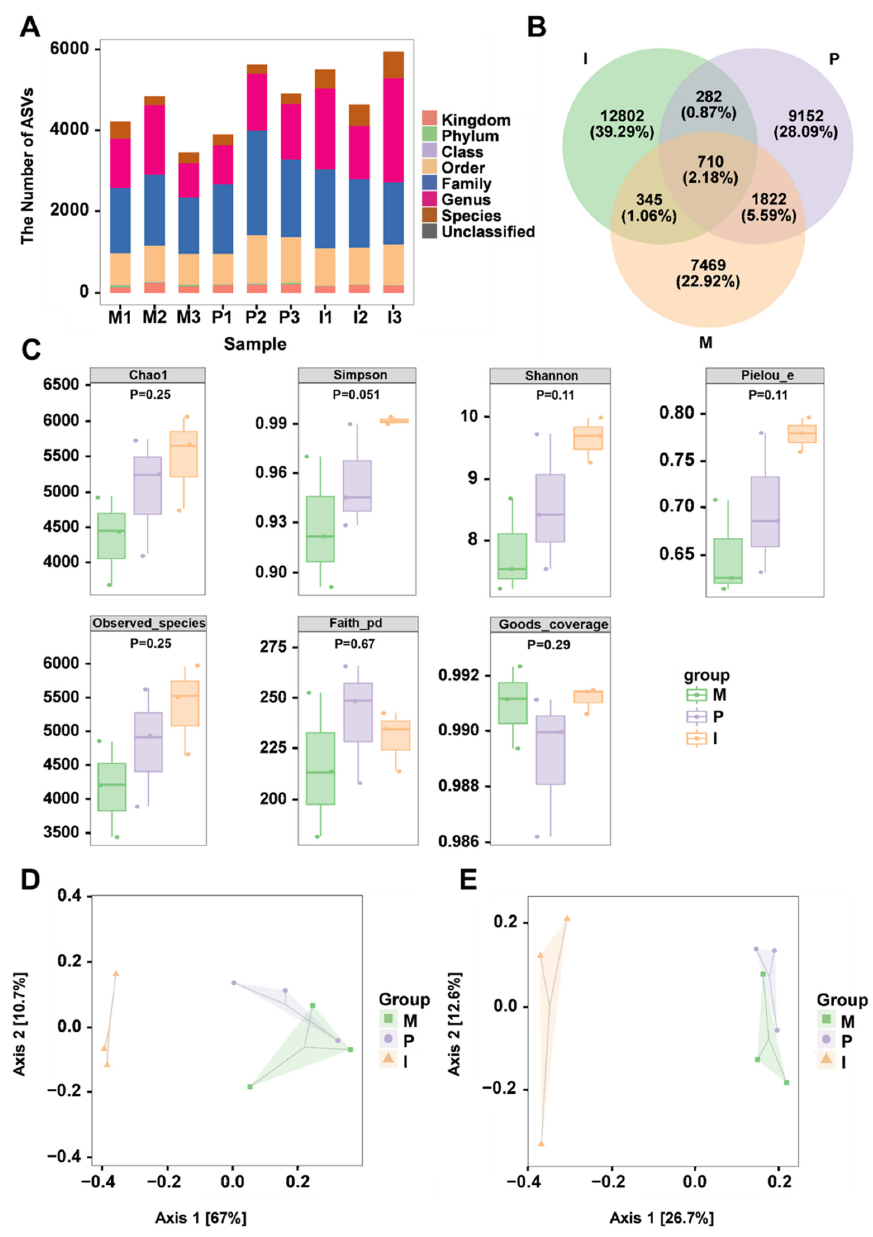
Figure 5. IRPS modulated the composition of gut microbiota. ( A ) The quantity of ASVs in different piglet samples; ( B ) Venn diagram of comparison of ASV distribution in different groups; ( C ) Com- parison of the microflora microbial diversity index (Chao1, Simpson, Shannon, Pielou’s evenness, Observed species, Faith’s PD) between piglet groups; ( D ) weighted UniFrac distance-based PCoA; ( E ) unweighted UniFrac distance-based PCoA. Axis 1 (X) and 2 (Y) represent the main axes of objects changing in two-dimensional space. Each point in the graph represents a sample, and the dots of different colors indicate different groups of samples. The closer the projection distance of the two points on the coordinate axis, the more similar the community composition of the two samples in the corresponding dimensions.